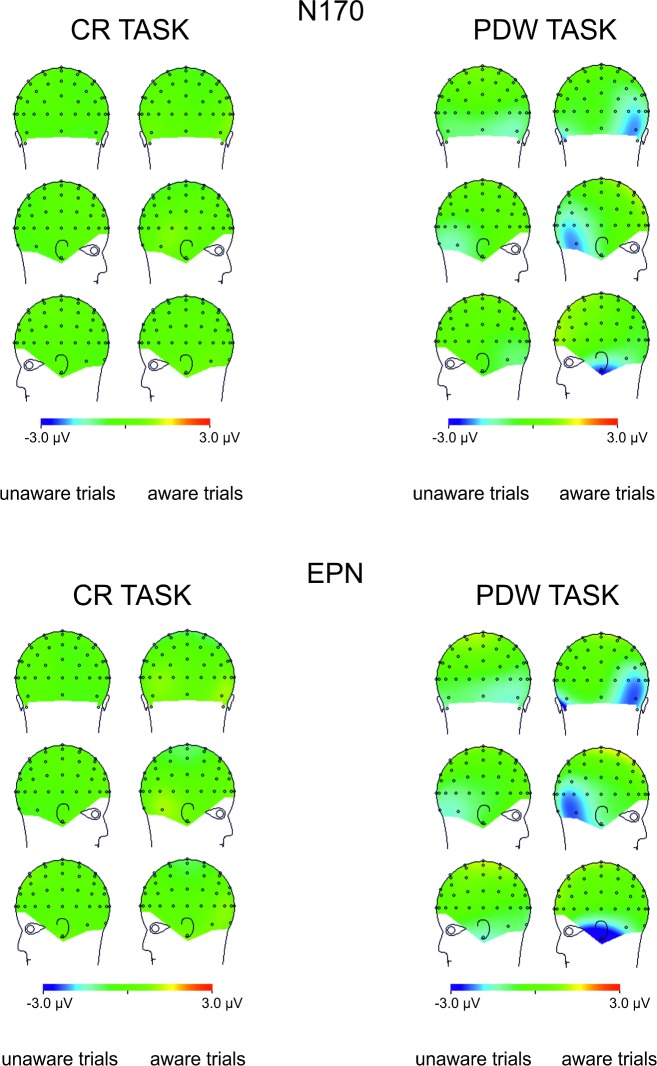
Topographical maps representing voltage differences between brain activity recorded in response to fearful and neutral faces in the N170 and EPN components time interval (145-180ms post-stimulus and 240-340ms post-stimulus, respectively) illustrated separately for “aware” and “unaware” trials.